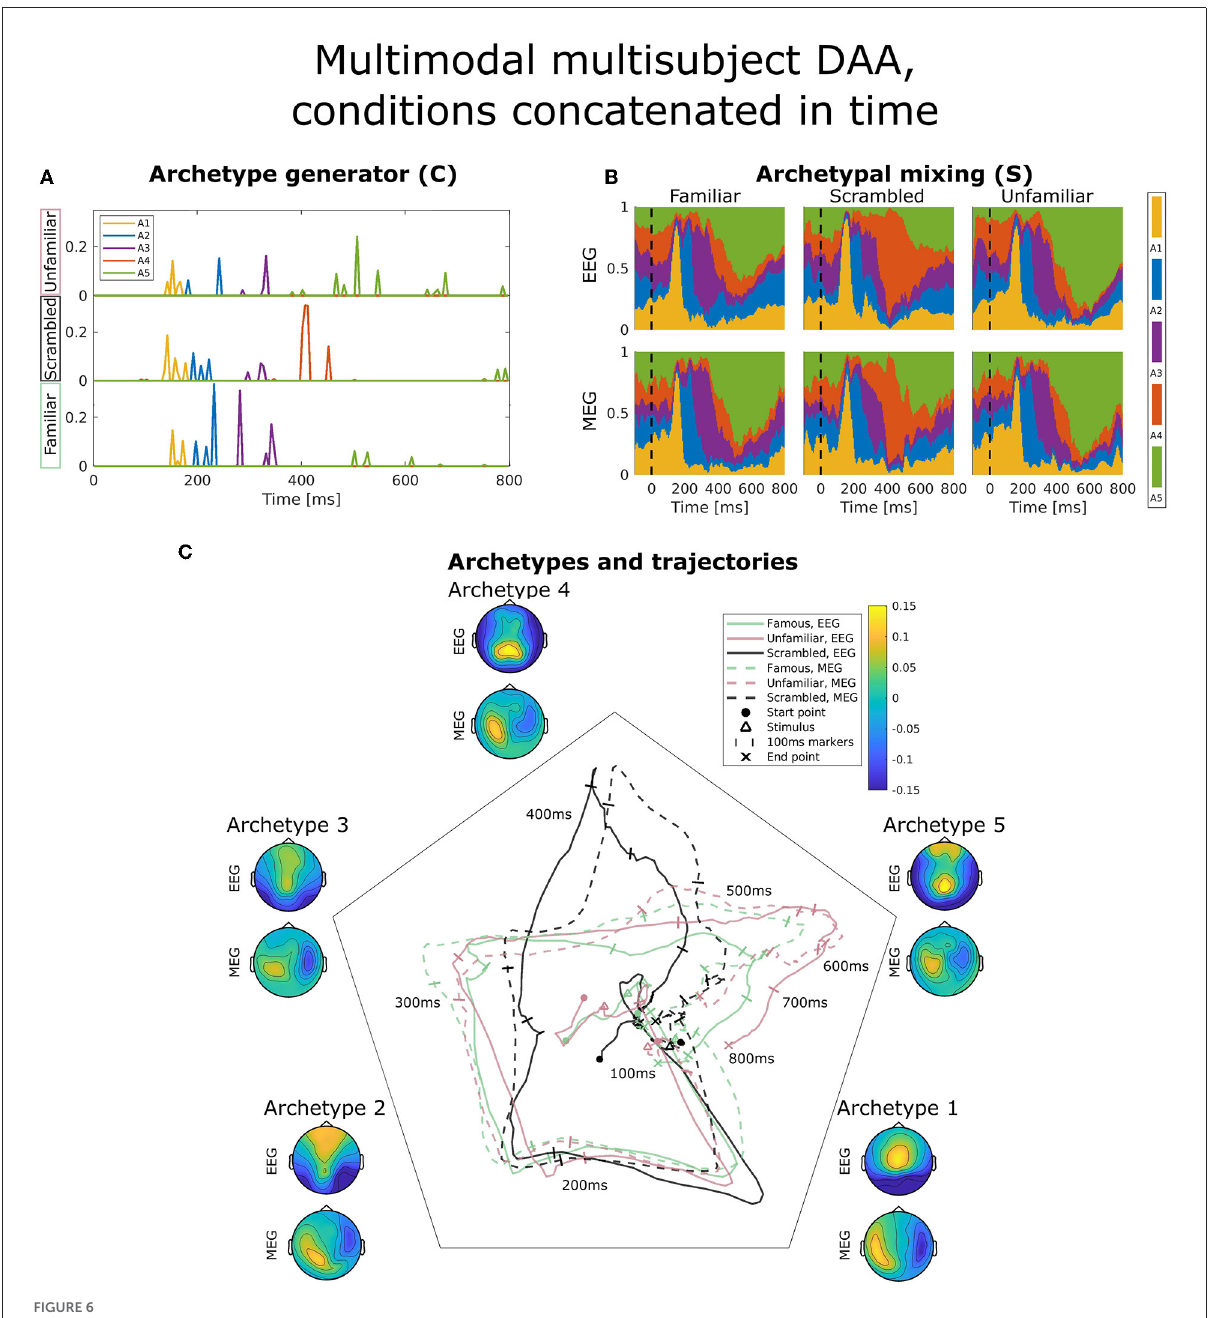
FIGURE6 Visualization of the best obtained fit for multimodal, multisubject DAA with K 5 components, where the three conditions have been = concatenated in time for all subjects and modalities prior to modeling to enforce equal archetypes. (A) The subject- and modality-shared archetype generator matrix C with information on the specific samples from which archetypes are generated. The matrix has been split into three parts corresponding to the three conditions and subsequently stacked for visualization purposes. (B) The archetypal mixing matrix S averaged across subjects showing how samples are probabilistically allocated to archetypes. The mixing matrix has been smoothed with a rectangular window of size 3 samples. (C) Archetype trajectory averaged across subjects based on the mixing matrix S smoothed with a rectangular window of 10 samples as well as average archetype topographical